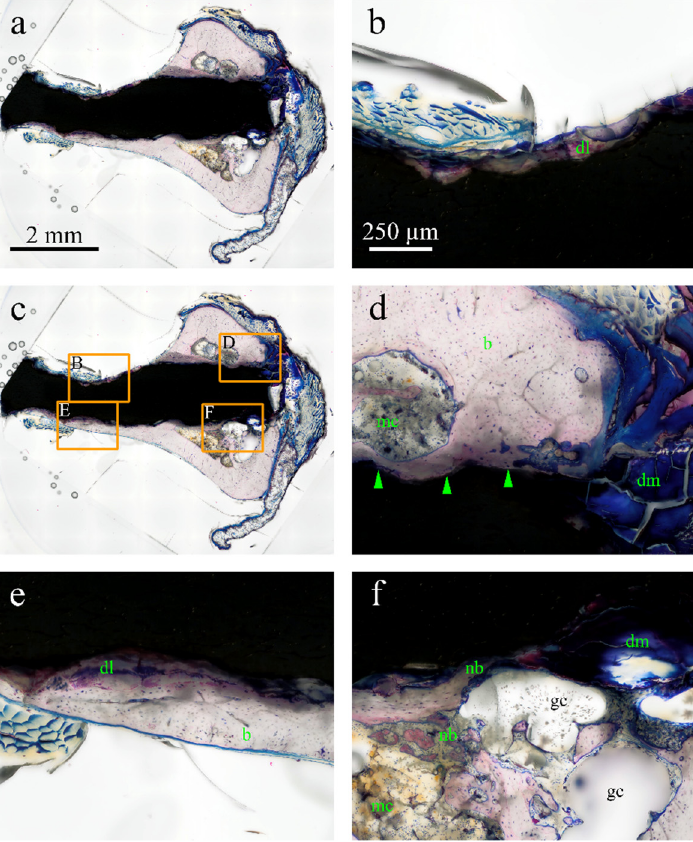
Figure 7. Representative photomicrograph of the proximal metaphysis of the rat tibia 24 weeks after implantation of LX41. ( a , c ): overview (scale bar = 2 mm) of the LX41 pin transcortically implanted into the tibia; ( c ): with labeling of the detail regions. ( b – f ): magnifications (scale bar = 250 µ m) of the respective region of interest indicated by orange rectangles. The pinkish color indicates bone, whereas the blueish color mostly indicates connective tissue. B: in pink going into blue a degradation layer (dl) without any cells or bone in contact. ( d ): medullary cavity (mc) surrounded by bone (b) adjacent to degradation material (dm) in blue, green arrowheads indicate bone in close contact to the implant ( e ): degradation layer (dl) in close contact to bone (b). ( f ): newly formed bone (nb) adjacent to gas cavity (gc) and medullary cavity (mc), degradation material (dm) can also be seen here. Levai–Laczko staining.